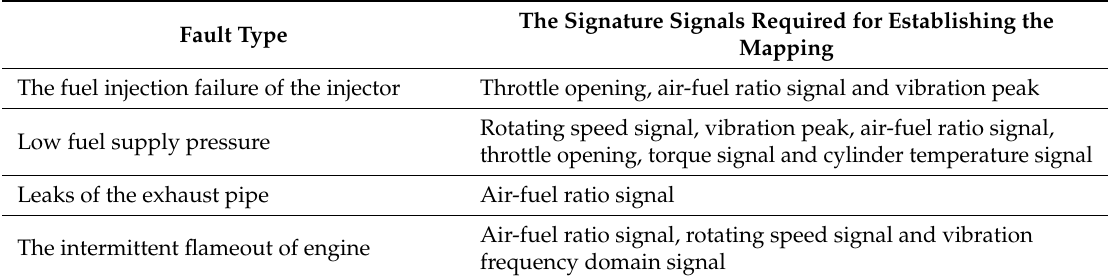
Table 1. Mapping relationship between fault types and characteristic signals.